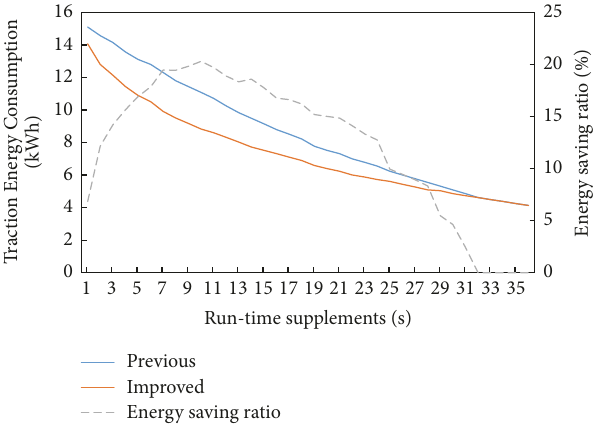
Figure 14: Energy-saving effect of the improved driving strategy at different